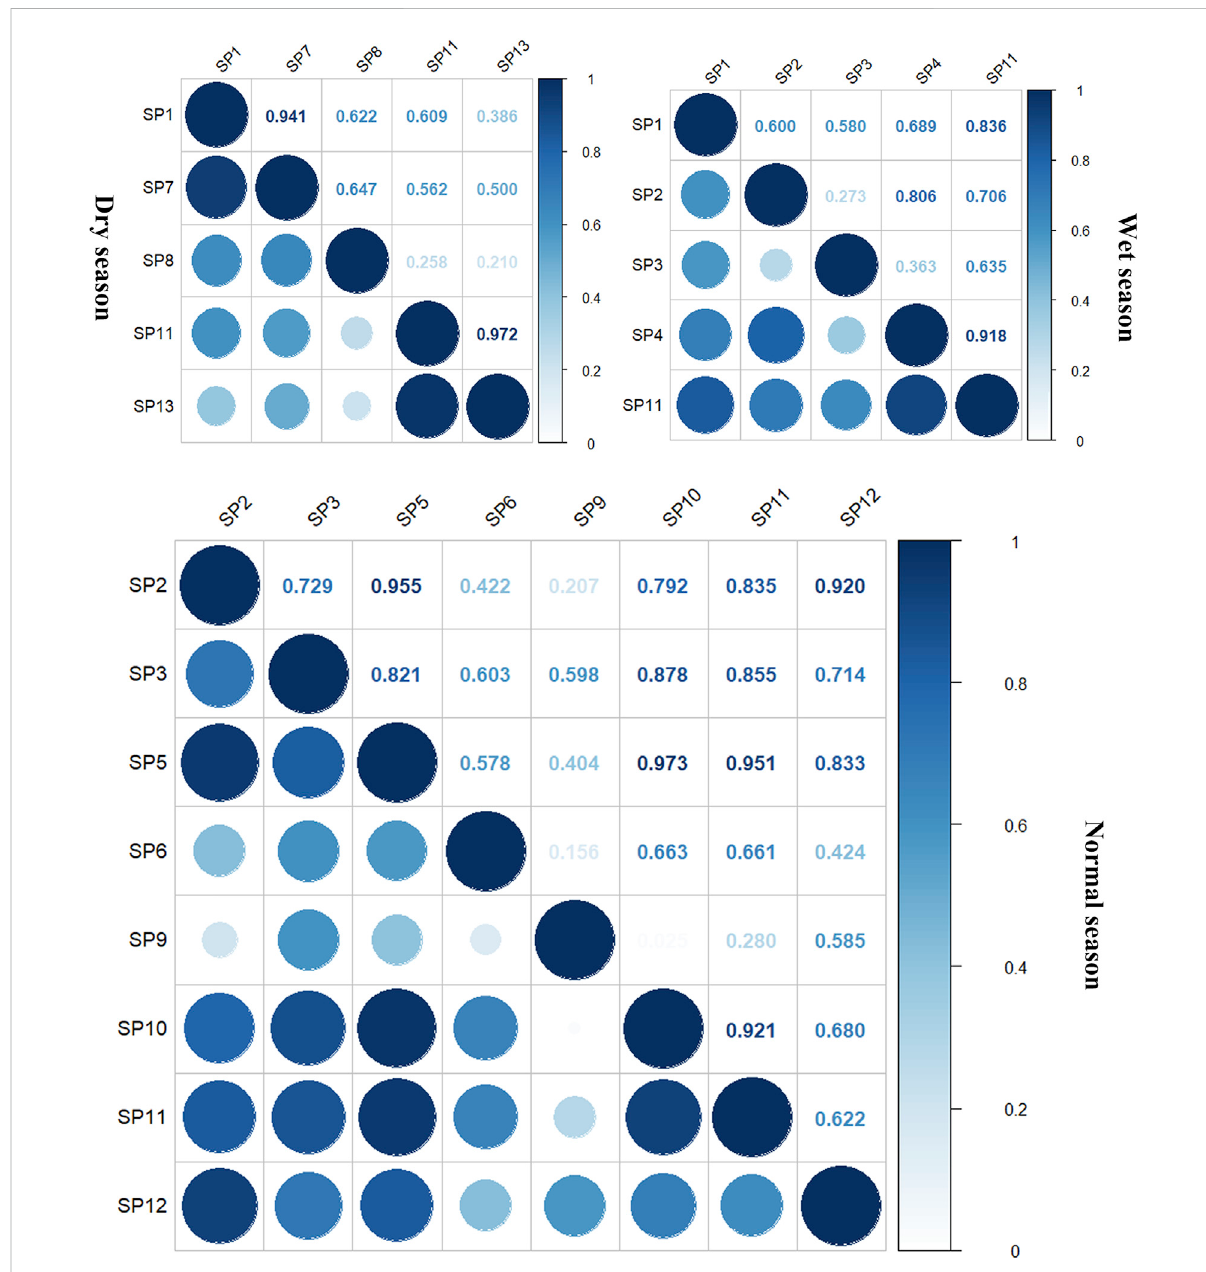
FIGURE 4 Variationsinthenicheoverlap( O ik )ofthedominantphytoplanktonspeciesindifferenthydrologicalseasons.Thedominantspeciesnumberand their corresponding relationships in the fi gure were consistent with those in Table